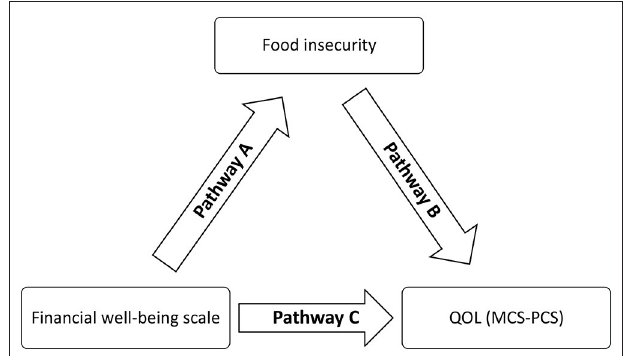
FIGURE 1 | The framework showing the mediation pathways between financial wellbeing, food insecurity, and quality of life.